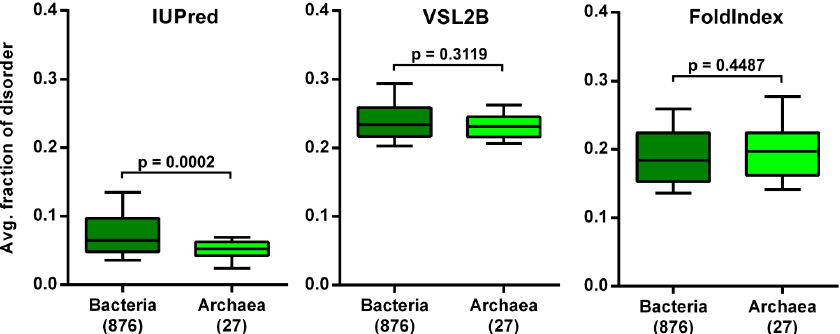
Figure 6. Comparison of the disorder levels of mesophilic Bacteria and Archaea. The average fraction of disordered residues was calculated for each proteome by three prediction methods and the resulting distributions were compared between Bacteria and Archaea by Mann–Whitney U tests, with p-values and the number of proteomes in the two groups